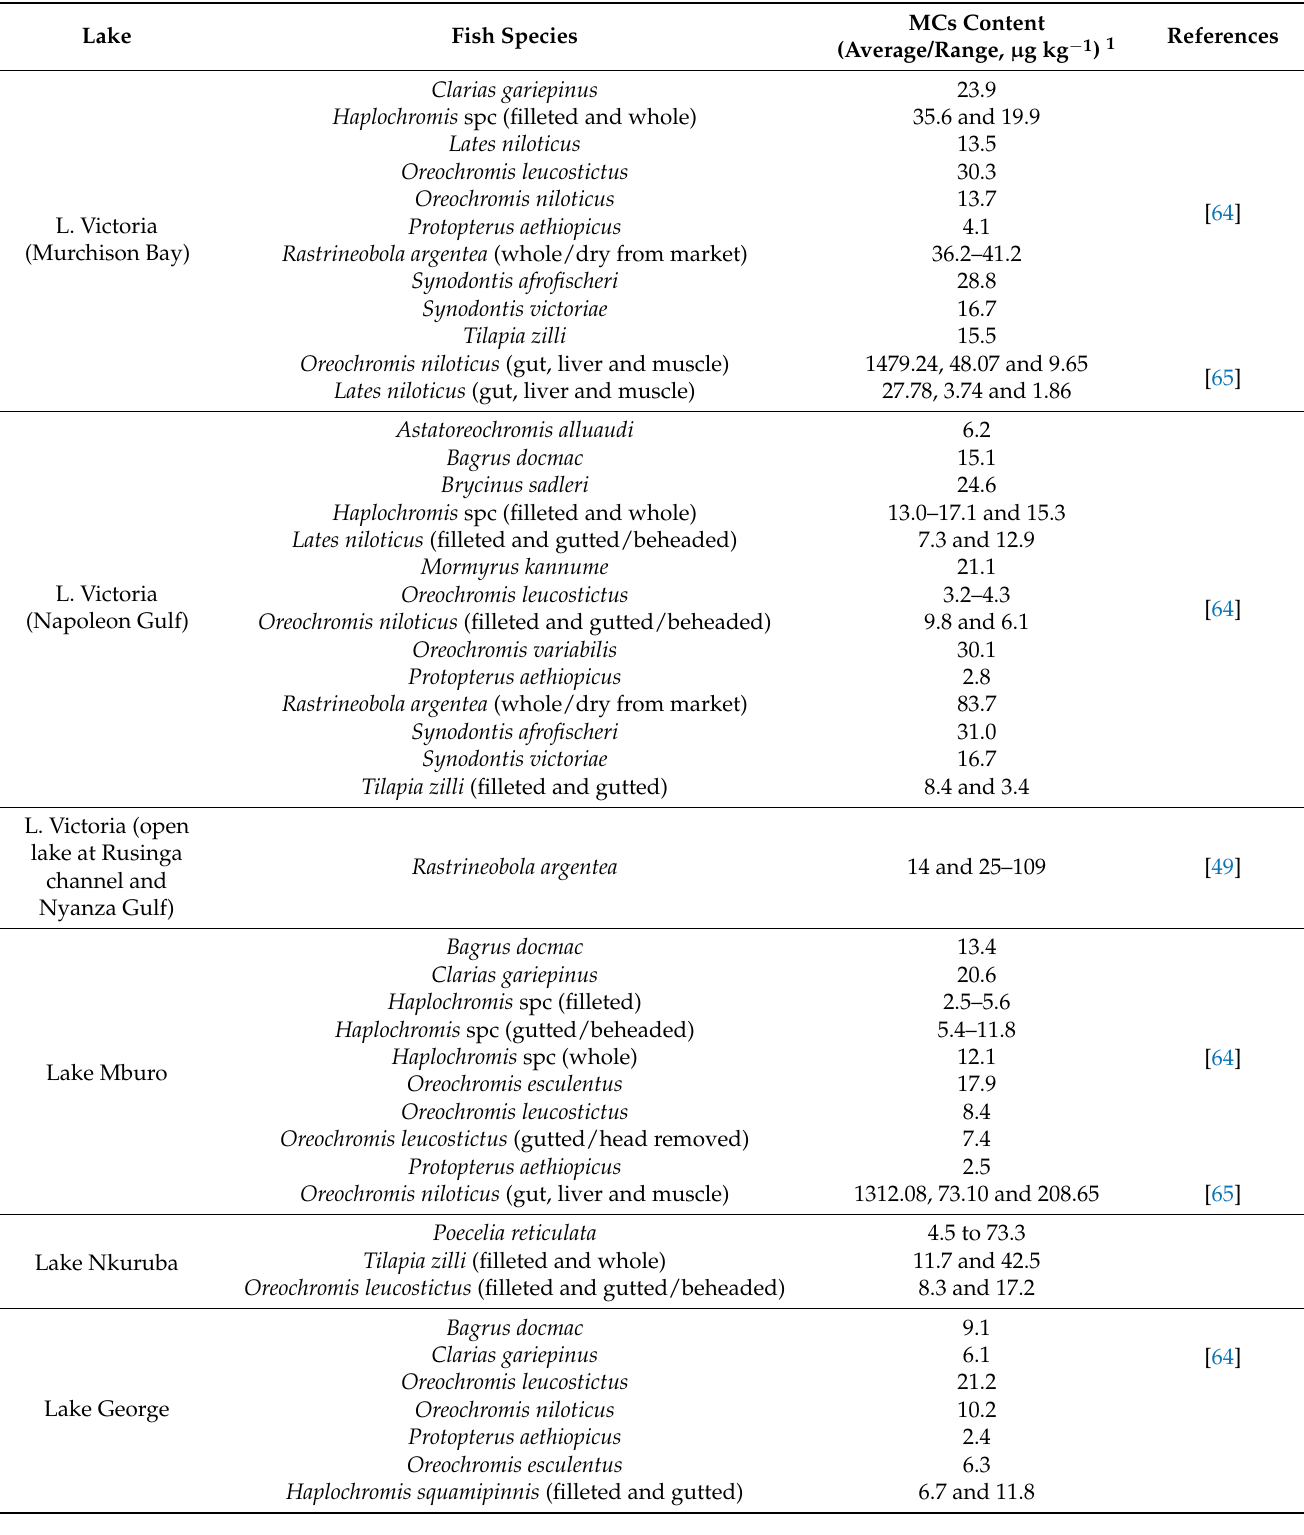
Table 1. Occurrence and levels of microcystins in fish from some East African